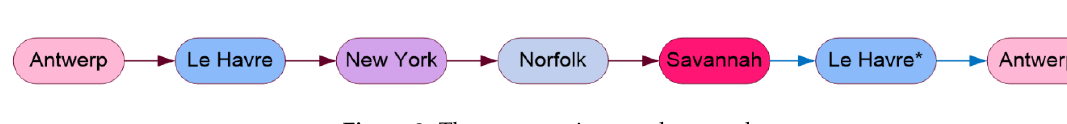
Figure 1. A liner shipping route example.